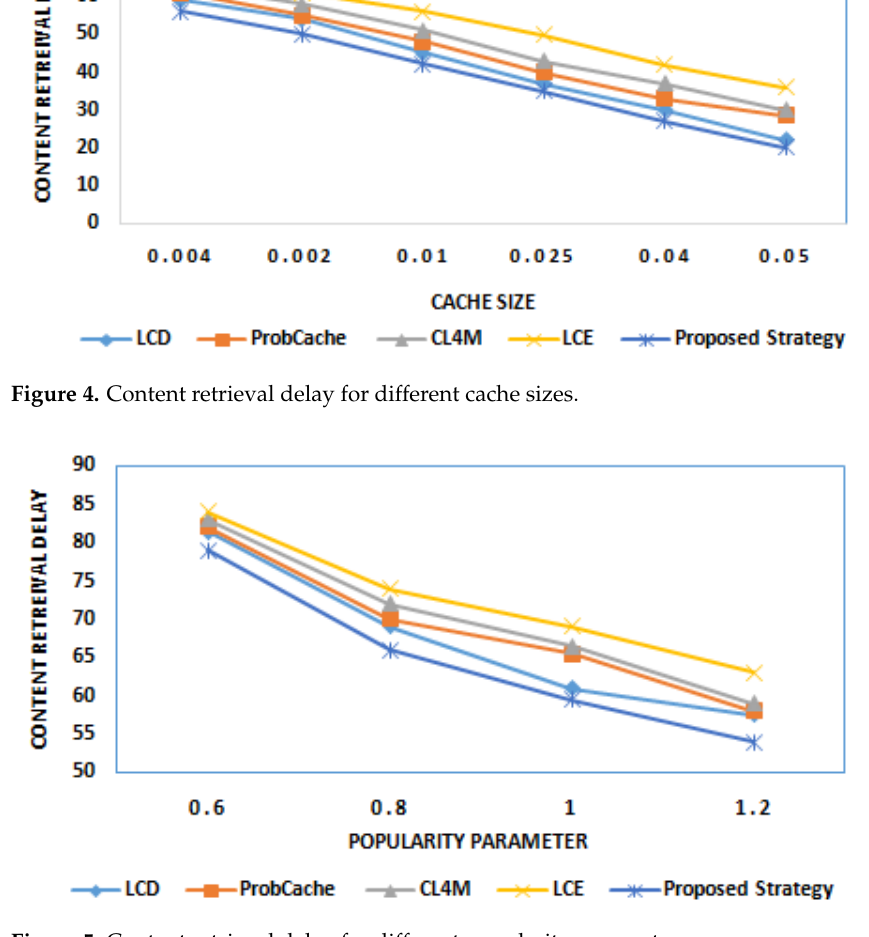
Figure 5. Content retrieval delay for different popularity parameter α